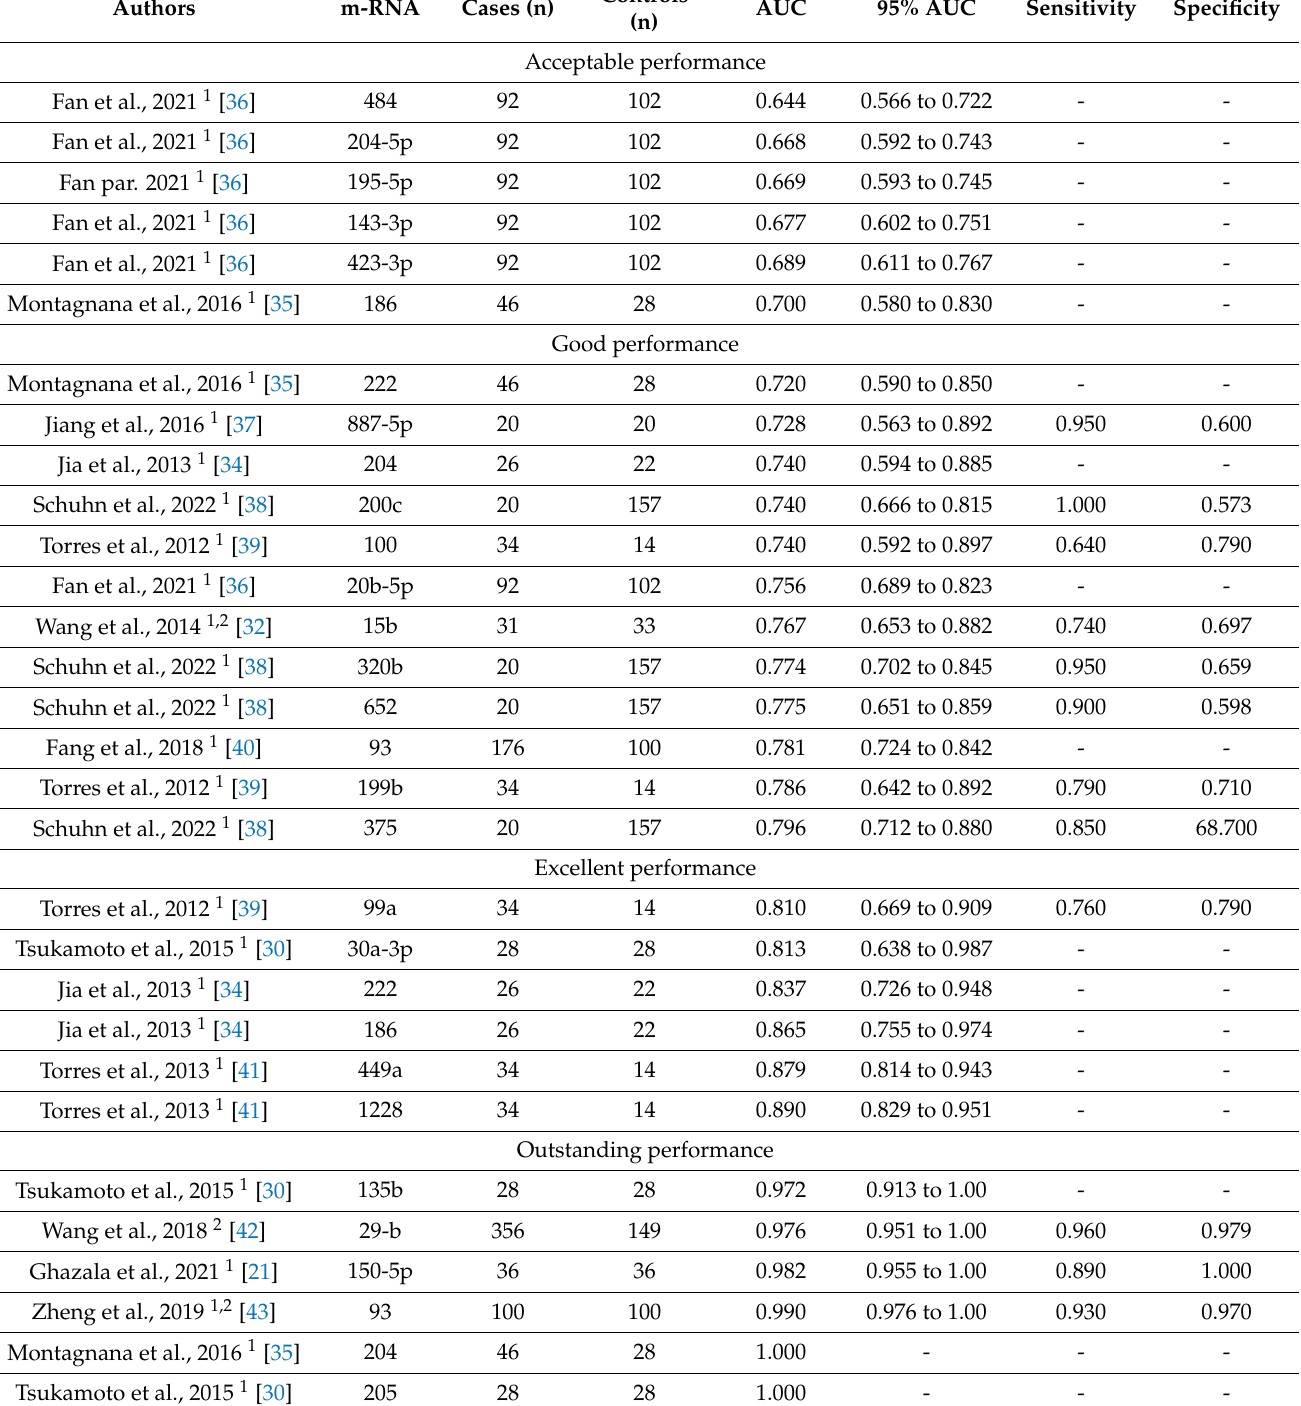
Table 1. Summary table of performance of Micro-RNAs for detection of endometrial